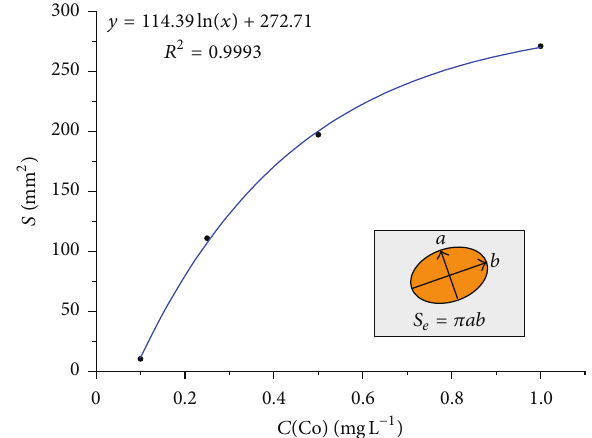
Figure 5: Concentration dependence of the colored spot area for Co(II) determination by the reaction of pyrocatechin